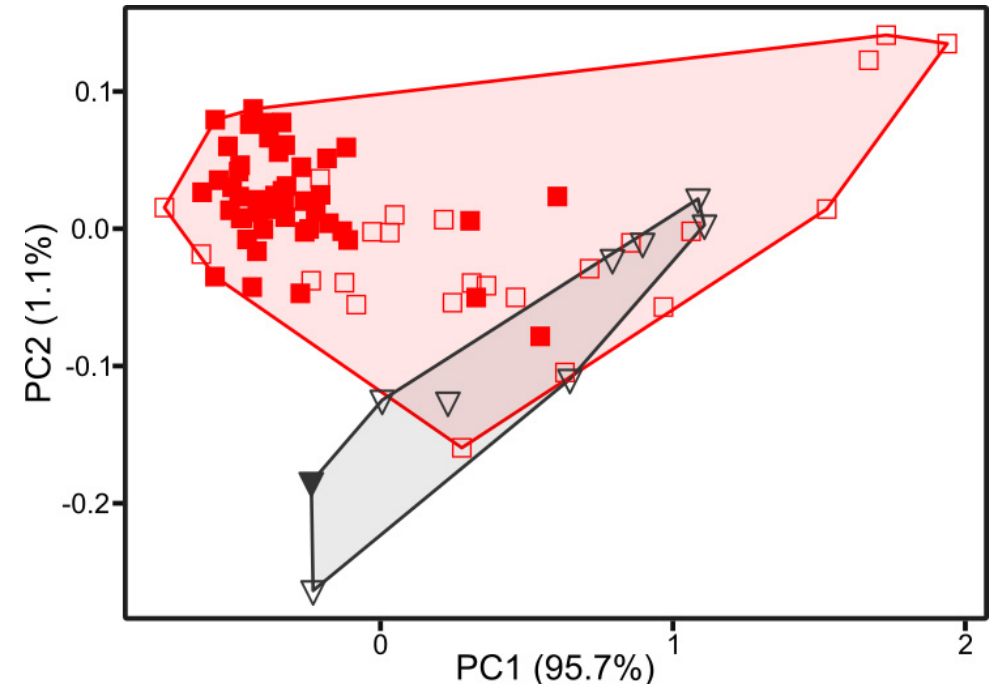
Fig. 6. Scatterplot of PC2 against PC1 of the PCA (n = 83) on 24 log-transformed measurements. For group B, the filled squares (■) represent the specimens used for the genetic analysis, the open squares (□) indicate the additional specimens of the Lake Edward system and the two specimens from Tshambi. Specimens of E. mimus (Boulenger, 1912) (lectotype) (▼) and E. mimus (paralectotypes) ( ▼